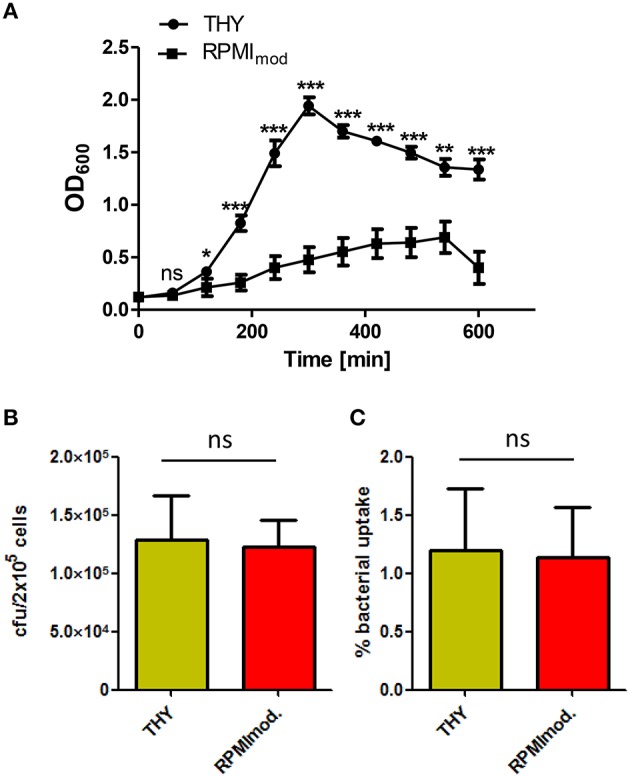
Influence of the cultivation medium on pneumococcal phagocytosis. (A) Growth curves of S. pneumoniae 35A grown in complex medium (THY) or chemically defined medium (RPMImod.). The significance of the THY-medium is based on the difference to RPMImod. (B,C) Phagocytosis of S. pneumoniae 35A after growth in THY or RPMImod. PMA-differentiated THP-1 cells (2 × 105) were infected (30 min) with a pneumococcal MOI of 50 at 37°C and 5% CO2. After infection, extracellular pneumococci were killed by the addition of Gentamycin and Penicillin G (incubation at 37°C and 5% CO2 for 1 h). The number of intracellular bacteria was determined by plating cell lysates on blood agar and visualized as recovered cfu (A) or % bacterial uptake of the infection dose (B). Values represent means ± SD of at least three independent experiments. ns = not significant, p > 0.5; *p < 0.05; **p < 0.01; ***p < 0.001.